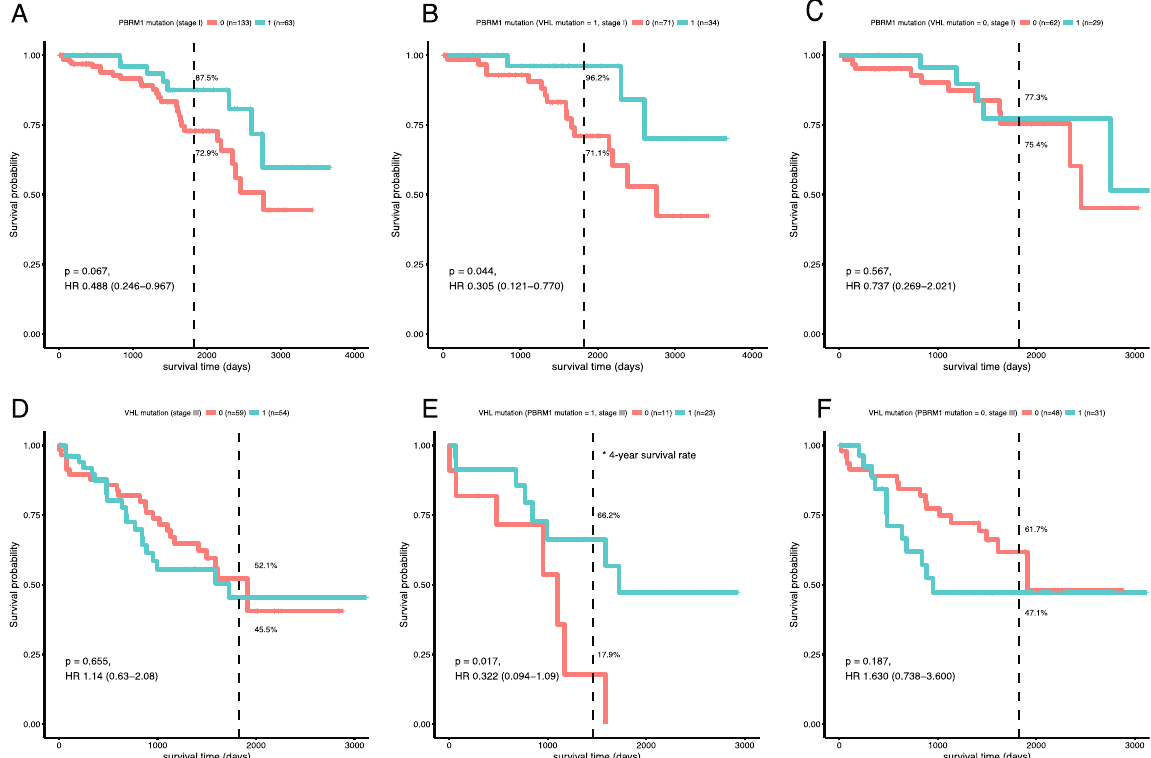
Figure 3. Stage specific survival analysis. ( A ) Survival curve for PBRM1 mutations in stage I. ( B ) Survival curve for PBRM1 mutations with VHL mutations in stage I. ( C ) Survival curve for PBRM1 mutations without VHL mutations in stage I. ( D ) Survival curve for VHL mutations in stage III. ( E ) Survival curve for VHL mutations with PBRM1 mutations in stage III. ( F ) Survival curve for VHL mutations without PBRM1 mutations in stage III. Dash line represents the time point of 5